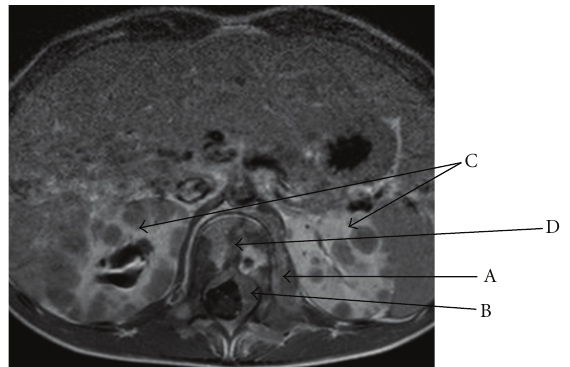
Figure 4: MRI (axial T1 gadolinium) lumbar paravertebral tumor (A) with epidural compression (B) through foraminae infiltration; bilateral nodular nephromegaly (C); heterogeneity captation of the vertebra (D), suggesting bone marrow